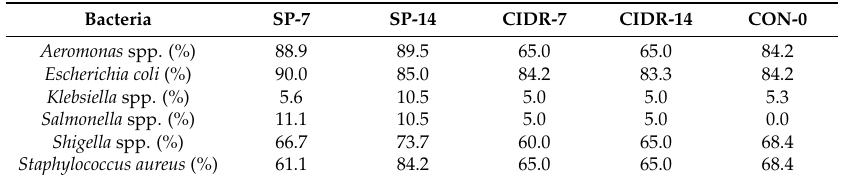
Table 2. Prevailing vaginal flora (%) at intravaginal device withdrawal in sheep treated with one progestagen-impregnated sponge for either 14 (group SP-14; n = 20) or 7 days (group SP-7; n = 20), one progesterone-loaded CIDR for either 14 (group CIDR-14; n = 20) or 7 days (group CIDR-7; n = 20), or no treatment (group CON-0; n =